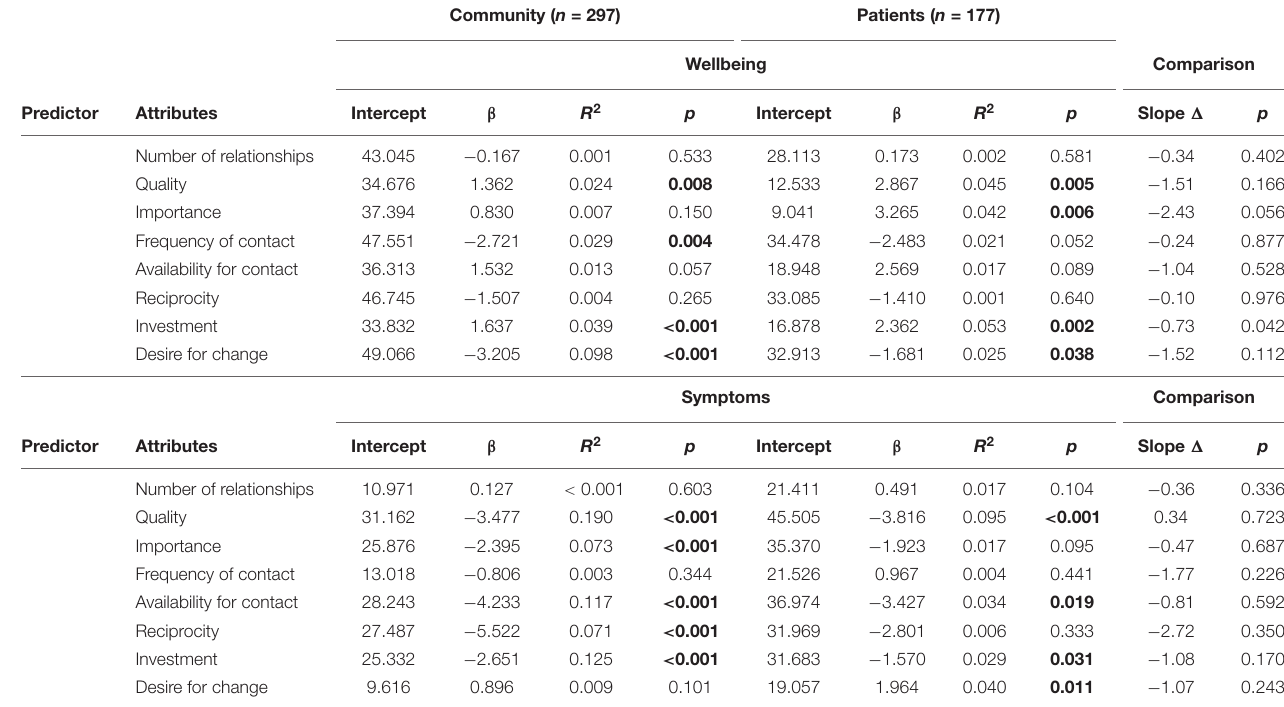
TABLE 4 | Linear regressions for relationship attributes with wellbeing or symptoms for the community and the patient sample. Community ( n = 297) Patients ( n = 177)